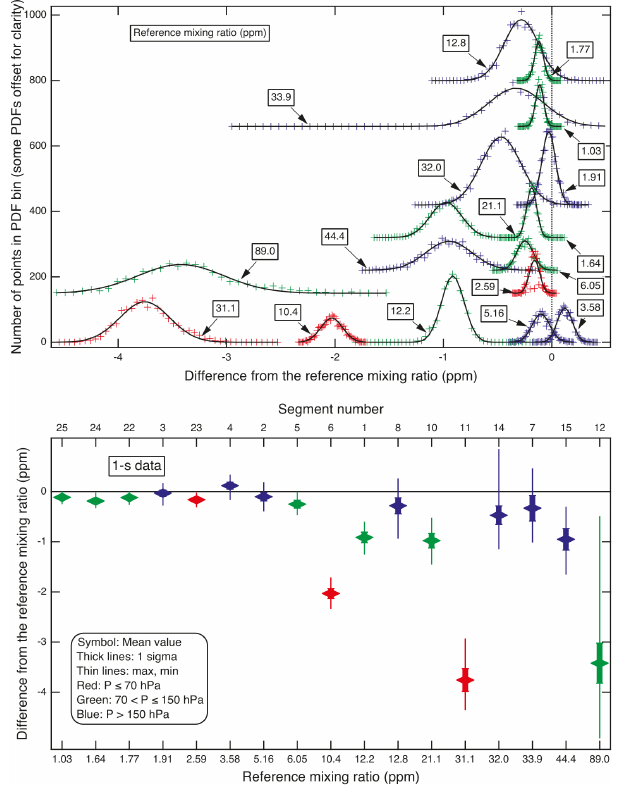
Figure 8. Example summary plot of measurement precision in the static experiments. The results shown are for the FISH-2 instrument. Top: Gaussian fits to the probability distribution functions (PDFs) of differences from the reference value function derived for each seg- ment from the core instruments. The PDFs are derived from the 1s time series data. Legend boxes indicate the reference water vapor value for each segment (see Table 3). The PDFs and fits are arbi- trarily offset in the vertical for clarity. The baseline symmetry in the Gaussian fits for each instrument indicates that the mean slopes comprising the ensemble mean are similar and, hence, slope differ- ences do not significantly affect the Gaussian widths. Bottom: plot of mean (symbols) and maximum and minimum differences from the reference values (thin vertical lines) and 1- σ precision (thick vertical lines) as defined in the footnote in Table 4. Color indicates the chamber pressure range in both top and bottom